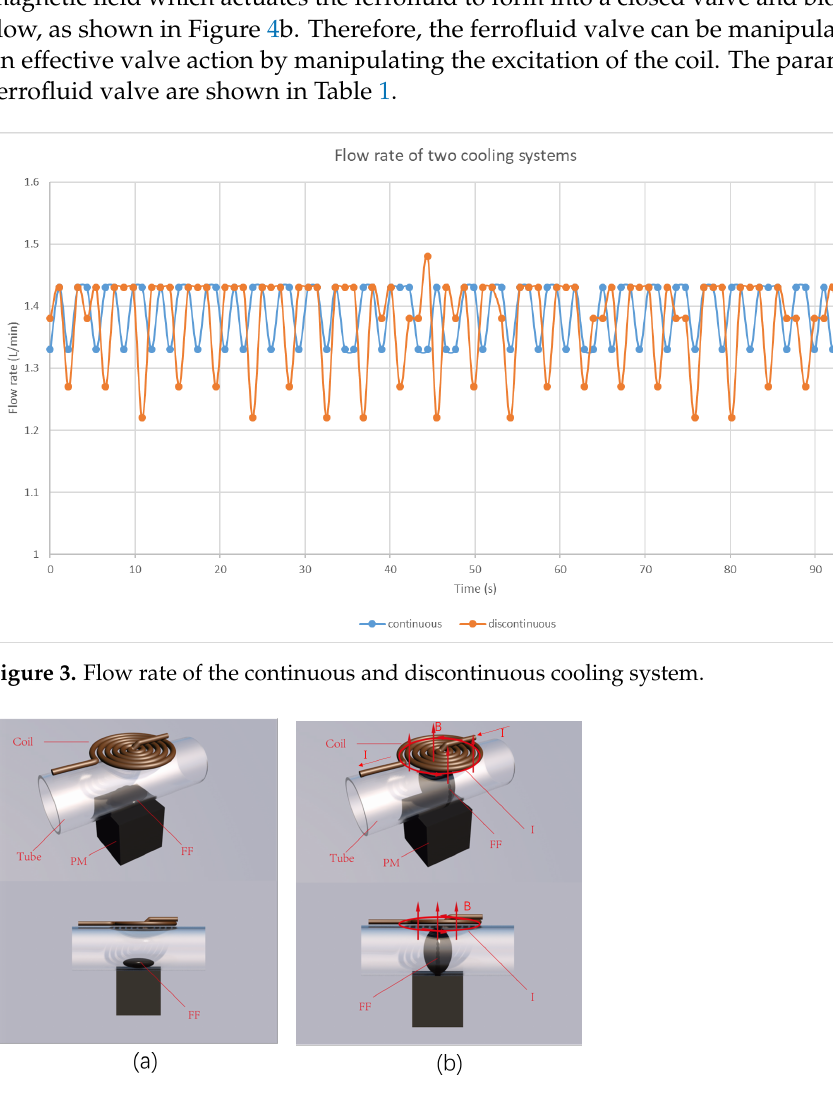
Figure 4. Ferrofluid-valve model: ( a ) coil excitation off, valve on; ( b ) coil excitation on, valve off. Table 1. Parameters of